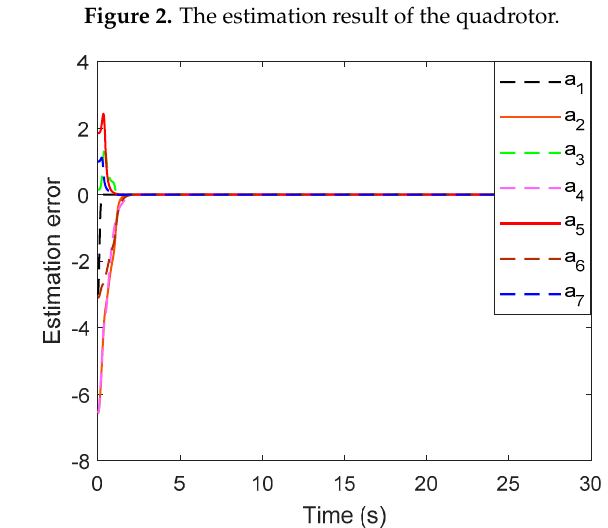
Algorithms 2018 , 11 , x FOR PEER REVIEW Figure 3. The estimation error of the quadrotor. Figure 3. The estimation error of the quadrotor. Figure 3. The estimation error of the quadrotor.